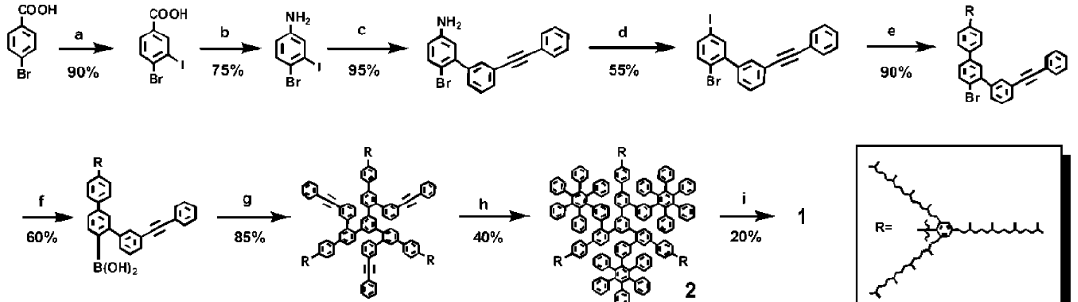
Figure 3. Suzuki reaction followed to prepare graphene dots (described as product number 1 in the reaction scheme) from bromobenzoic acid. Reproduced with permission of [36]. Steps are as follows: ( a ) NaIO 4 , I 2 , concentrated H 2 SO 4 , room temperature; ( b ) Heated with diphenylphosphoryl azide in triethylamine and tert-butanol at 80 °C, followed by treatment with CF 3 COOH in dichloromethane at room temperature; ( c ) Suzuki condition with 3-(phenylethynyl)phenylboronic acid, Pd(PPh 3 ) 4 , K 2 CO 3 in water, ethanol, and toluene mixture, 60 °C; ( d ) Iodine and tert-butyl nitrite in benzene, 5 °C to room temperature; ( e ) Suzuki condition with substituted phenyl boronic acid, Pd(PPh 3 ) 4 , K 2 CO 3 in water, ethanol, and toluene mixture, 80 °C; ( f ) Treatment with butyllithium in tetrahydrofuran (THF) at −78 °C, then with triisopropyl borate at −78 °C, followed by treatment with acidic water at room temperature; ( g ) Suzuki condition with 1,3,5-triiodobenzene, Pd(PPh 3 ) 4 , K 2 CO 3 in water and toluene mixture, 80 °C; ( h ) Tetraphenylcyclopentadienone in diphenylether, 260 °C; ( i ) FeCl3 in nitromethane and dichloromethane mixture, room temperature.